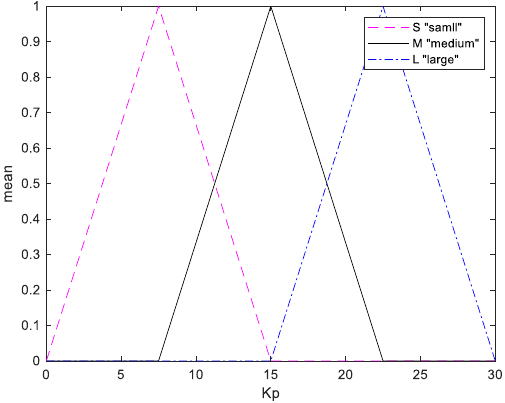
Figure 17. Membership functions of parameter Ki.